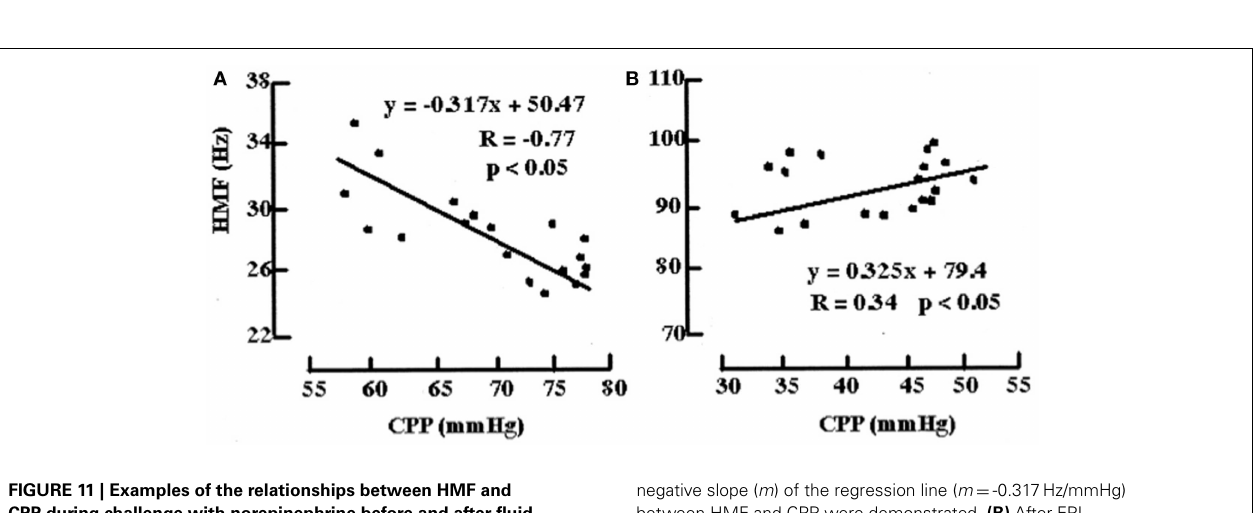
FIGURE 10 | Electrical equivalent circuit of the Czosnyka model (43) .This figure Illustrates the presence of three storage compartments ( C a = compliance of the great cerebral arteries, C v = compliance of capillaries, and small veins, C i = compliance of the CSF containers). Other parameters are arterial blood pressure (ABP), cerebral arterial pressure in the small